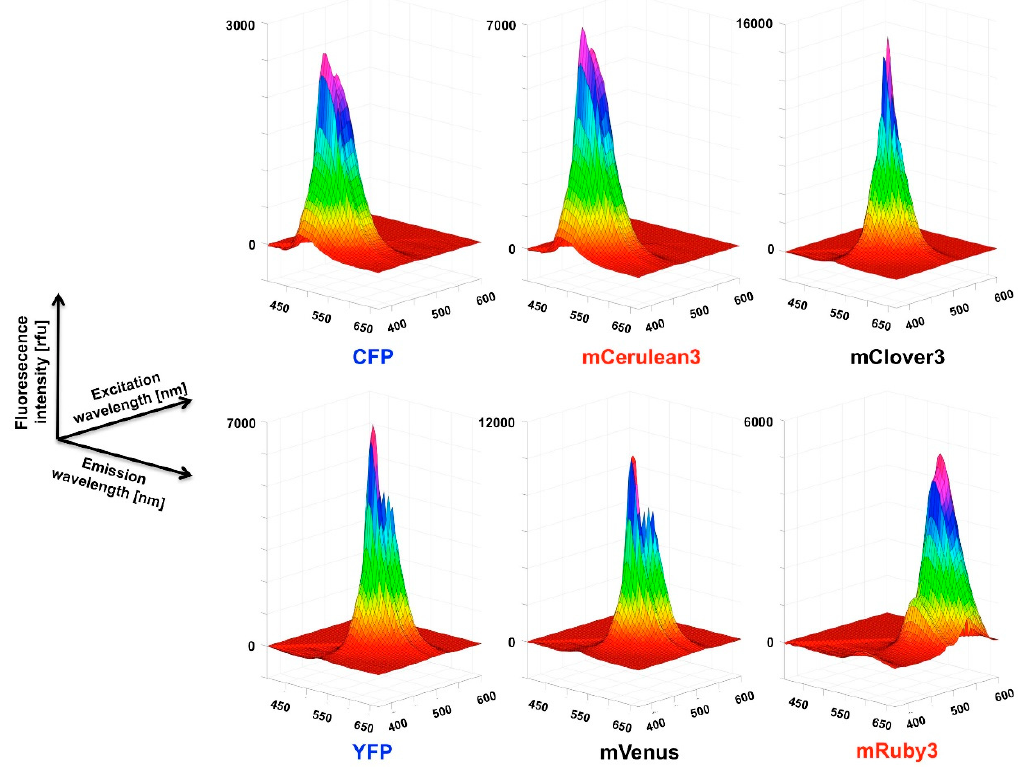
Figure A2. 3D fluorescence spectra of proteins relevant to the present study. Spectra were recorded as described in Materials and Methods and visualized in MATLAB. The original figures that can be freely rotated in real time on the computer screen to better explore the surface are provided as Supplemental Material. Despite the limits of the present two-dimensional representation it can be seen that CFP and mCerulean3 have a very similar shape of their spectra, with the major difference being the higher intensity observed with mCerulean3. A very similar relation is evident for YFP and mVenus, where mVenus has the higher fluorescence intensity.